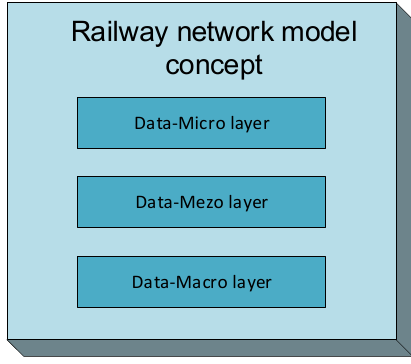
Figure 3. Concept of a three-layer rail line